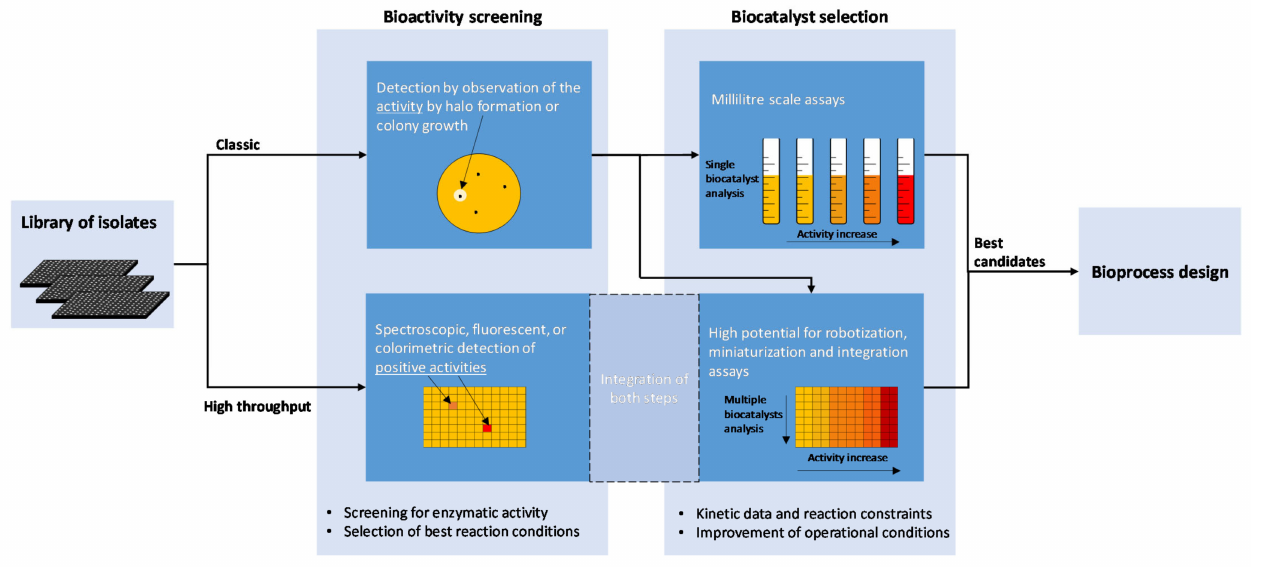
Figure 2. Traditional and high-throughput approaches for screening and selection of biocatalysts from a library of isolates, and assessment of the best bioreaction